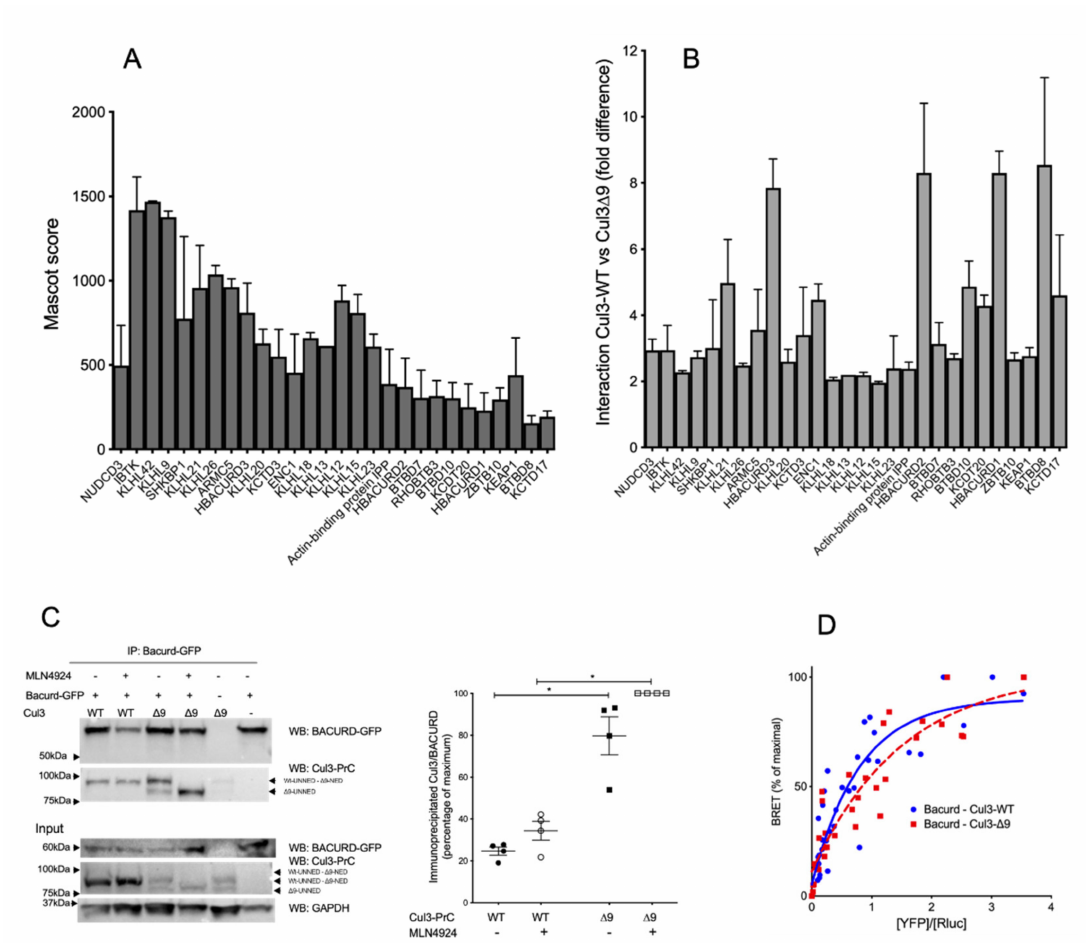
Figure 5. CUL3-WT and CUL3- ∆ 9 interactions with BTB-proteins. Upper part: ( A ). and ( B ). in- teractions of BTB proteins with CUL3-WT and CUL3- ∆ 9 analyzed by MS/MS. PrC-CUL3-WT and PrC-CUL3- ∆ 9 were immunoprecipitated with HPC4 antibody, and the immunoprecipitate was ana- lyzed by mass spectrometry. The abundance, as assessed by the Mascot score ( A ) and the difference in the interaction of BTB-proteins ( B ) with PrC-CUL3-WT and PrC-CUL3- ∆ 9 are shown. Lower part: interactions of Bacurd with CUL3-WT and CUL3- ∆ 9 analyzed by co-immunoprecipitation and BRET. ( C ). Bacurd-GFP was transfected in PrC-CUL3-WT or PrC-CUL3- ∆ 9 inducible cell lines (see Materials and methods). Cells were induced (or not) with tetracycline (10 µ g/mL) 32 h post-transfection and treated (or not) with MLN4924 (1 µ M) (Millenium Pharmaceuticals) 42 h post-transfection. Co-immunoprecipitation of Bacurd-GFP was performed by GFP-Trap followed by SDS-PAGE and transfer to nitrocellulose. On the left, a representative gel of the co-immunoprecipitation experiment blotted with the HPC4 (CUL3) and GFP (Bacurd) antibodies is shown. On the bottom, a Western blot of the same cellular extracts for Bacurd, CUL3, and GAPDH is shown. On the middle, a scatter plot of the results obtained for three experiments is presented. The results are expressed as the percentage of the maximal ratio of immunoprecipitated CUL3/Bacurd normalized on the CUL3/GAPDH ratio observed on the input gel. Statistical comparisons used the Kruskal–Wallis test on CUL3/Bacurd ratios (* = p < 0.05). ( D ). The interaction of nanoluc-Bacurd with YFP-CUL3-WT and YFP-CUL3- ∆ 9 was analyzed by BRET experiments, as shown in Figure 2. Similar hyperbolic curves were obtained for CUL3-WT and CUL3- ∆ 9, with non-significant different BRET 50 (0.71 ± 0.16 and 1.01 ± 0.2, respectively, n = 3, p = 0.304). Statistical comparisons used the Student’s t